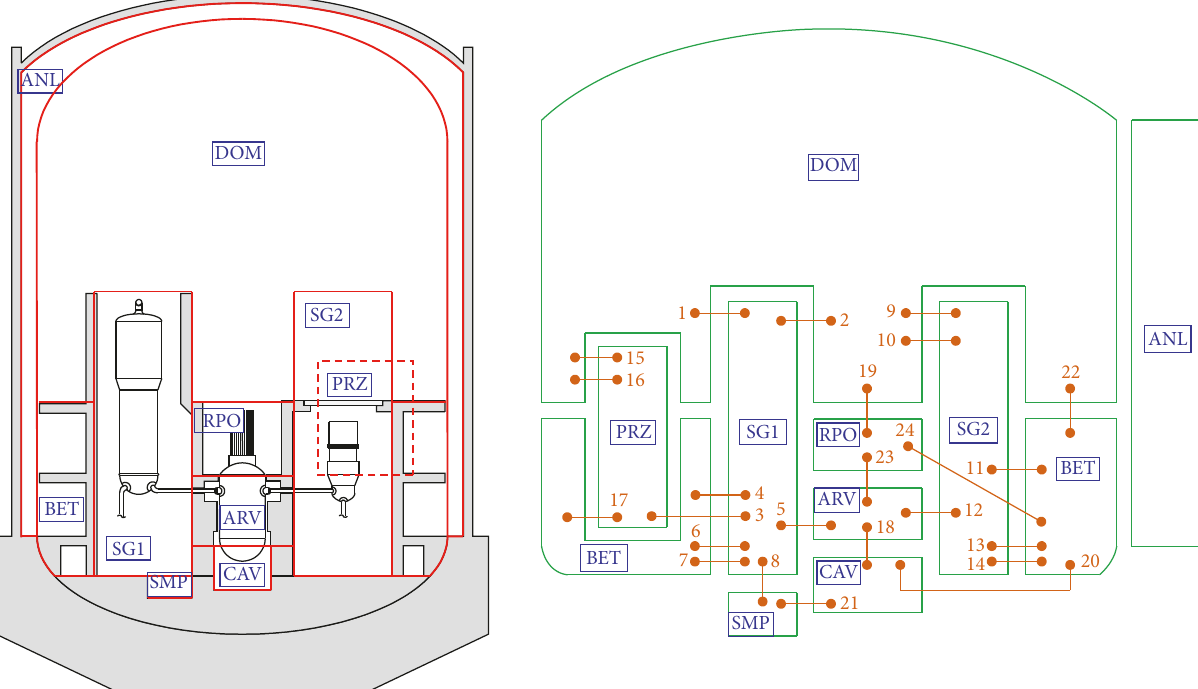
Figure 4: Containment nodalization scheme (representation of control volumes and junction connections).